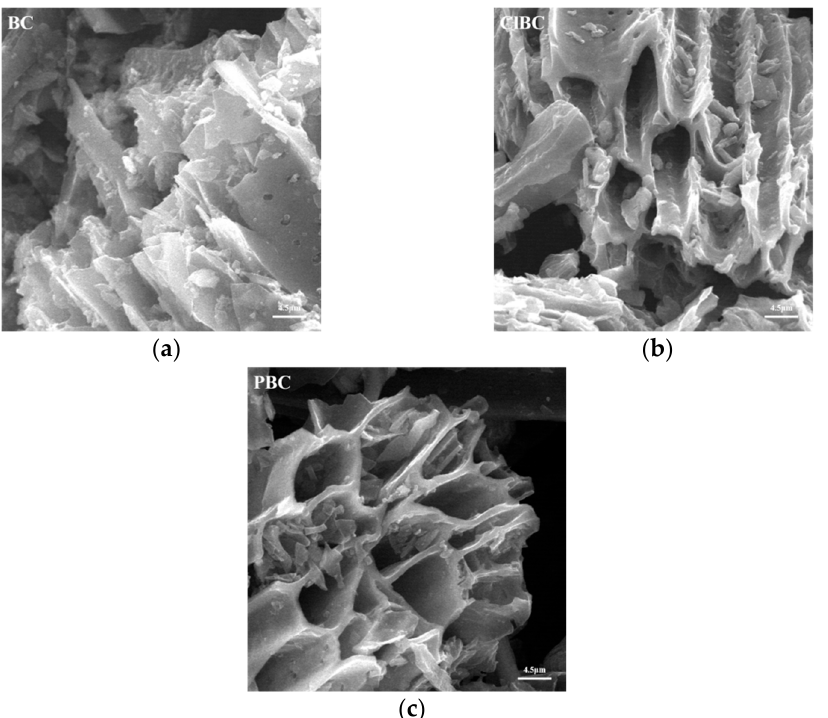
Figure 1. SEM images of modified biochars ( a ) raw bochar, ( b ) HCl ‐ modified biochar and ( c ) H 3 PO 4 ‐ modified biochar.